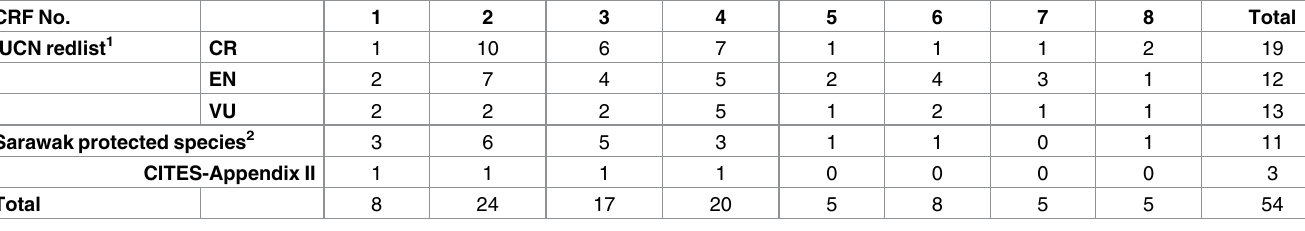
Table 2. Number of species in the IUCN Red List and Sarawak protected species. CRF